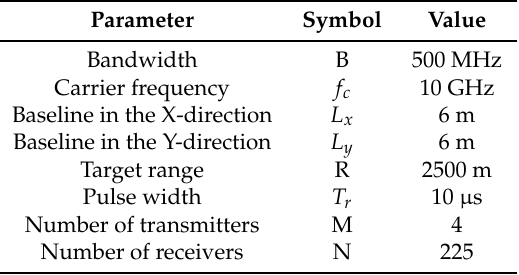
Table 2. Simulation Conditions.